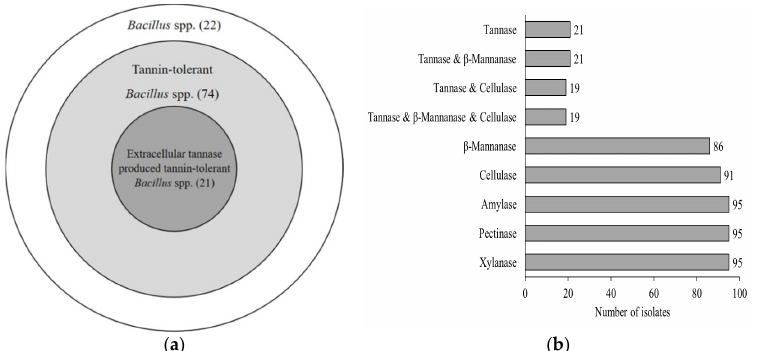
Figure 1. Venn diagram showing the number of Bacillus spp. isolated from Miang based on their tannin-tolerant characteristic ( a ) and a bar graph comparing the different extracellular enzyme characteristic of tannin-tolerant Bacillus spp. isolates ( b ).